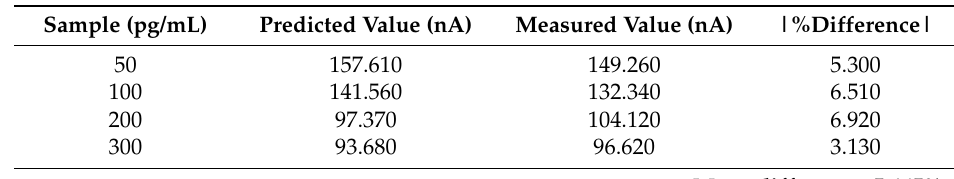
Table 1. Assayed IFN γ spiked serum samples were compared to a calibration curve from IFN γ titrated in buffer to indicate the accuracy of clinical measurements. Percentage difference using the fit equation: